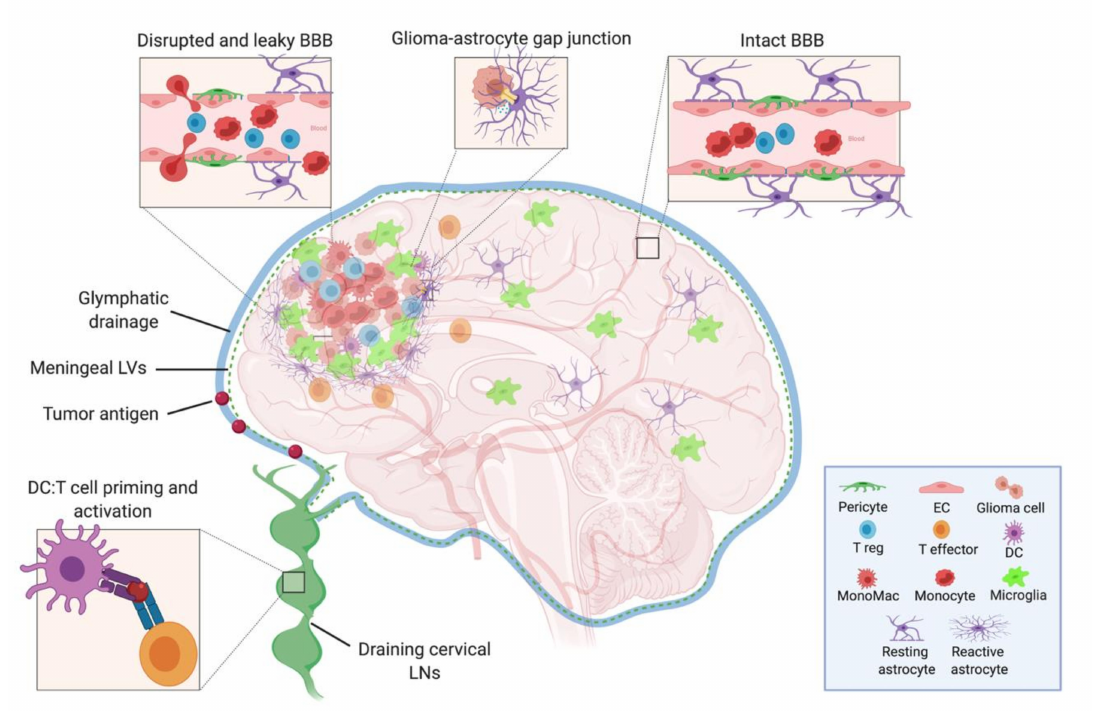
Figure 1. Model depicting the cells of the intact and leaky BBB, the cellular components of the neuroimmune system in the brain, and the tumor microenvironment. The CSF, meningeal lymphatic, and glymphatic fluids drain to the deep cervical LNs, where DCs that have captured either CNS or tumor antigens can present to and activate naïve T cells. Within the tumor, there are suppressive Tregs, monocytes, monocyte-derived macrophages, microglia, and reactive astrocytes—the latter of which may act in an aberrant wound healing manner to wall o ff the lesion and inadvertently exclude e ff ector T cell from entering. BBB: blood–brain barrier, CSF: cerebrospinal fluid, LN: lymph node, DC: dendritic cell, EC: endothelial cell, LV: lymphatic vessel. (Created with